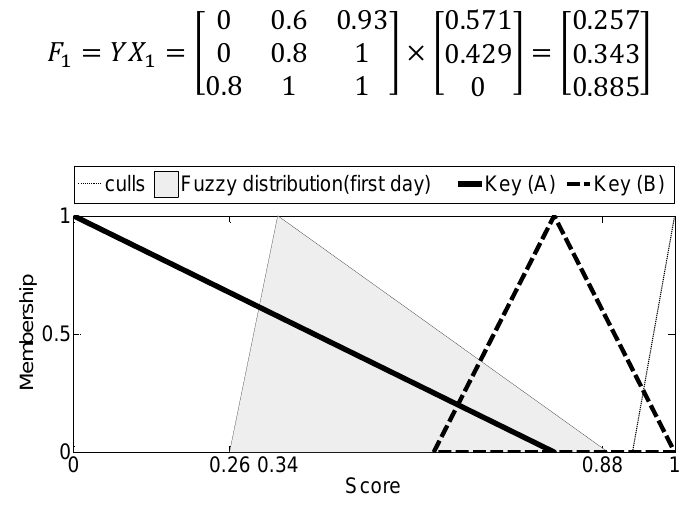
Fig. 6. The fuzzy distribution for first